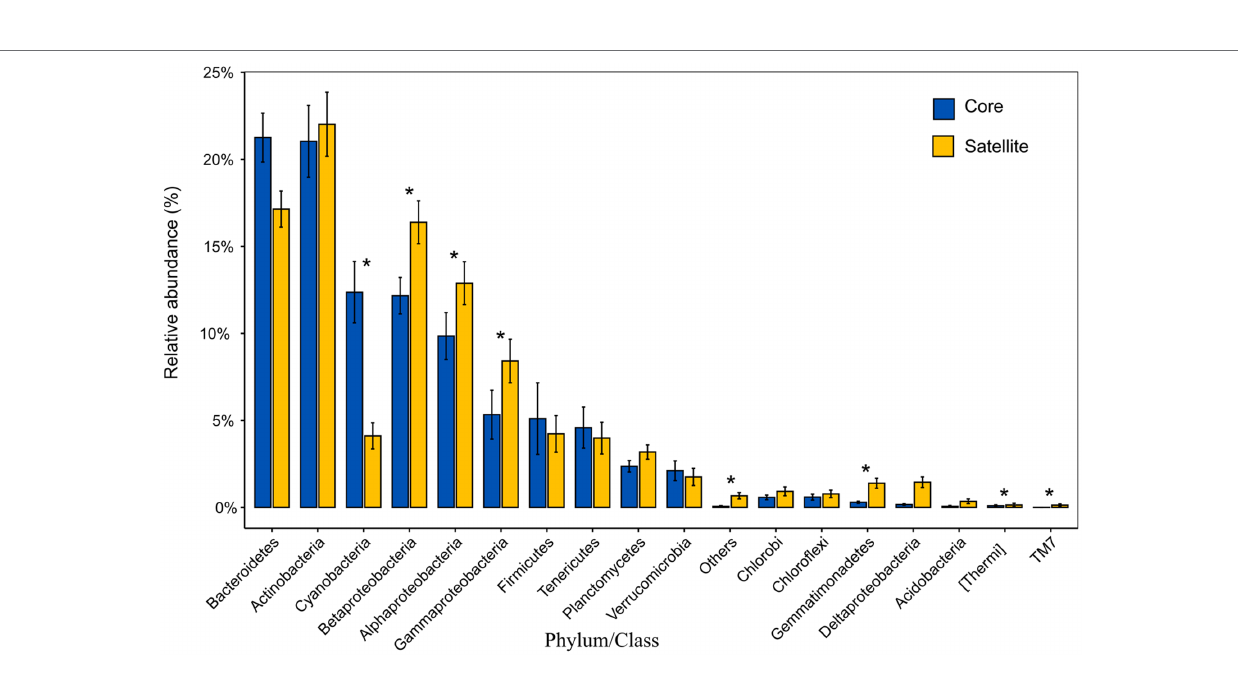
FIGURE 2 | The relative abundance of the 18 common phyla and the classes of Proteobacteria within the core and satellite communities. Asterisks indicate significant differentially abundant phyla/class between the core and satellite bacterial sub-communities ( p <